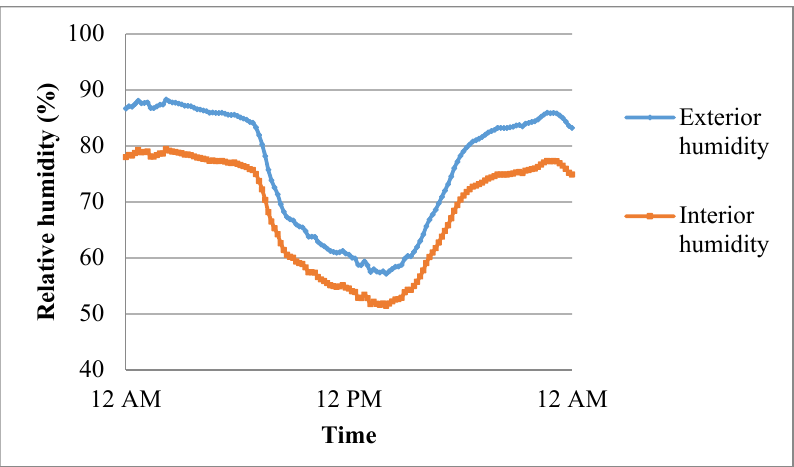
Figure 16. Dependencies for relative interior and exterior humidity during the model day in